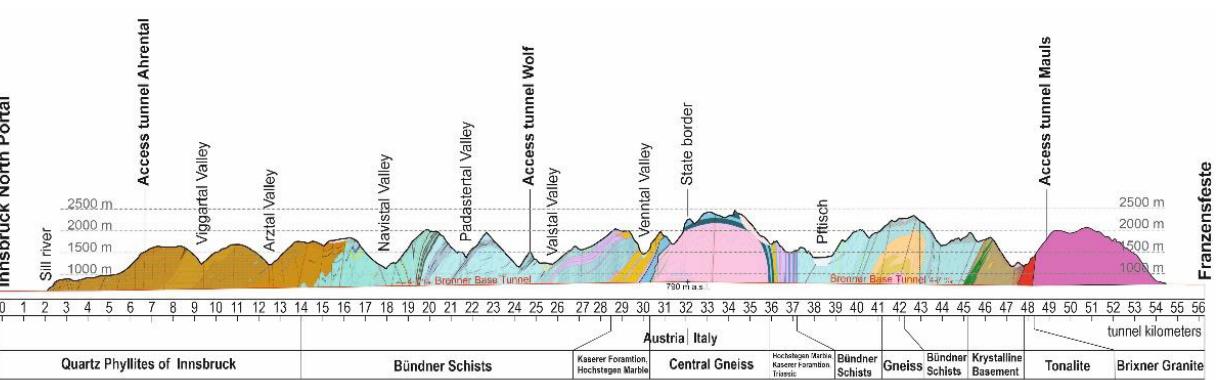
Figure 1. Location of the BBT, part of the Scandinavian – Mediterranean Corridor, for short Scan- Med Corridor, taken from [4]. On its path, the tunnel crosses different mountain ridges, valleys, and a complex crustal area in the alpine collision zone [5], with a maximum overburden of approximately 1700 m on the Italian side and approximately 1400 m on the Austrian side (Figure 2) [6].